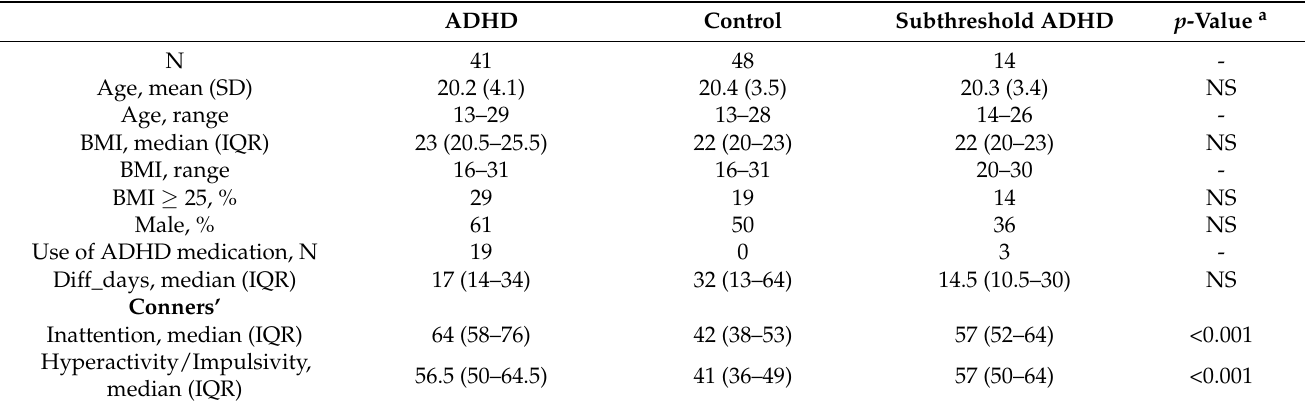
Table 1. Characteristics of the